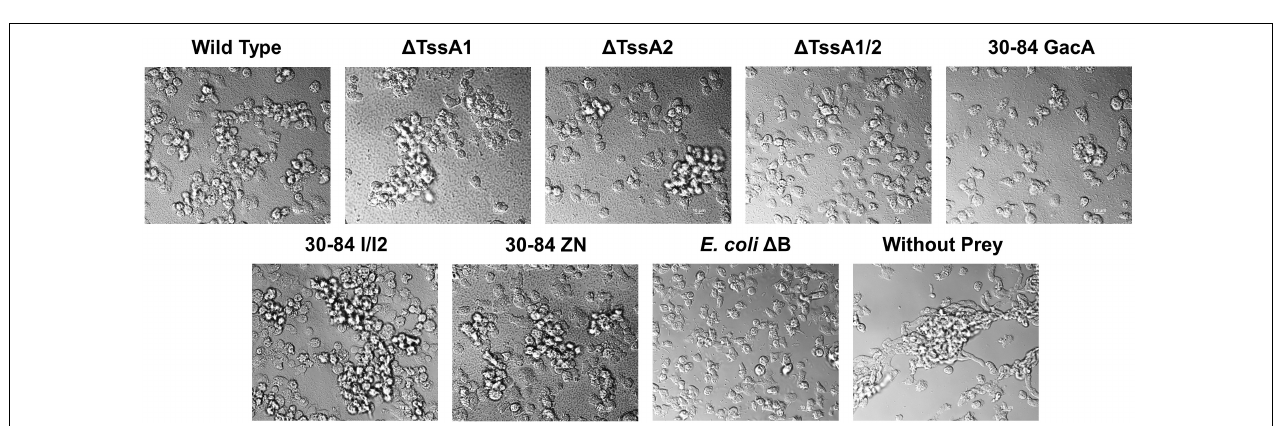
FIGURE 4 | Rhizosphere competition assays. The competitive fitness 30–84 WT, the single T6SS mutants, (cid:49) TssA1 and (cid:49) TssA2, and the double mutant, (cid:49) TssA1/2 were evaluated by comparing their populations when grown separately or in 50:50 mixtures with other Pseudomonas rhizosphere colonizing bacteria in the rhizosphere. Data are expressed as competitive ratios (population in mixture/population when grown separately). Gray scale bars (left) indicate performance of 30–84 WT and derivatives, and colored bars (right) indicate performance of competitors, including P. fluorescens 2–79 (yellow color, having no T6SS), P. protegens Pf-5 (green color, having a T6SS-1 homolog), and P. fluorescens Q2–87 (purple color, having three T6SS, including T6SS-1 and T6SS-2 homologs). After 28 days, bacterial populations from the entire root system and loosely adhering soil were collected and enumerated via serial dilution plating. Populations were standardized to root dry weight. Data are the mean competitive ratios of at least eight replicates pooled across three experiments ( n = 24) and standard errors are indicated.